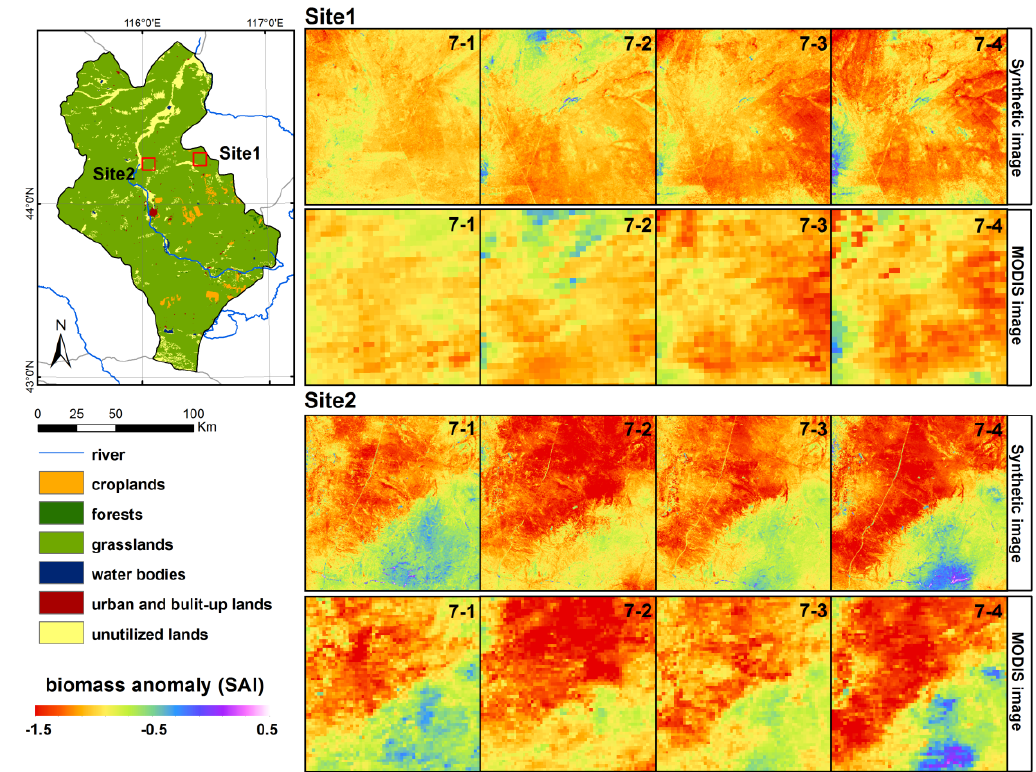
Figure 9. The Standardized Anomalies Index (SAI) indicating biomass anomalies in Xilinhot during July 2007. The land cover map in Xilinhot in the left panel was adapted from the land cover data set provided by the Data Center for Resources and Environmental Sciences, Chinese Academy of Sciences (http://www.resdc.cn). The unutilized lands represent lands that have not been used (including desert, Gobi region, saline, wetlands, bare soil).